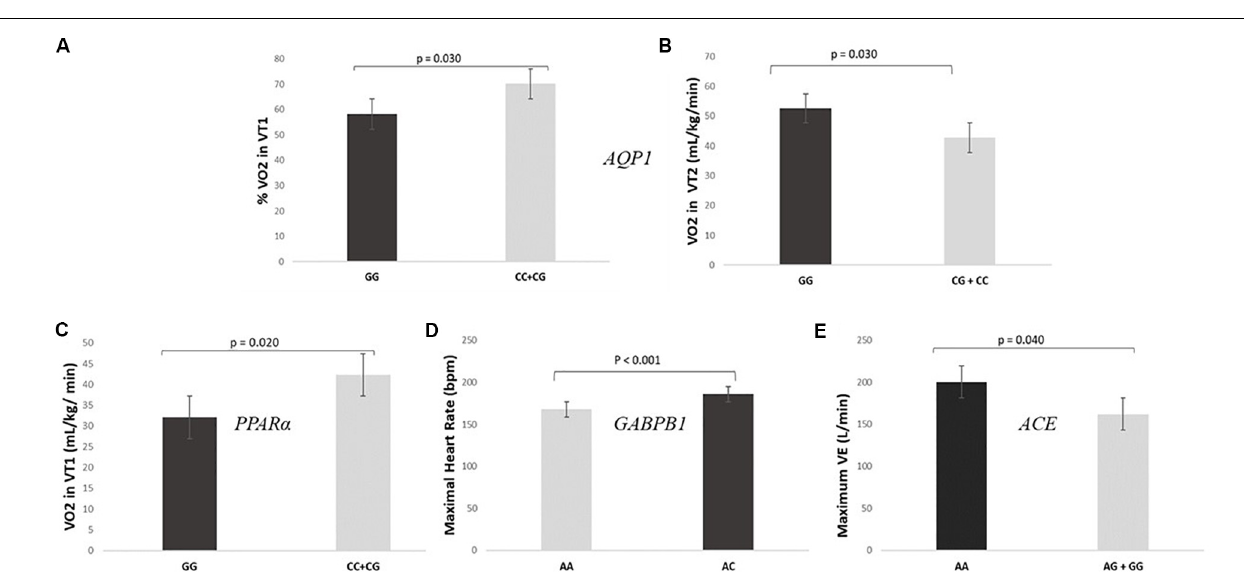
FIGURE 1 | Levels of VO 2 max (mL/kg/min) during the cardiopulmonary exercise test according to the genetic endurance prediction score (GES).